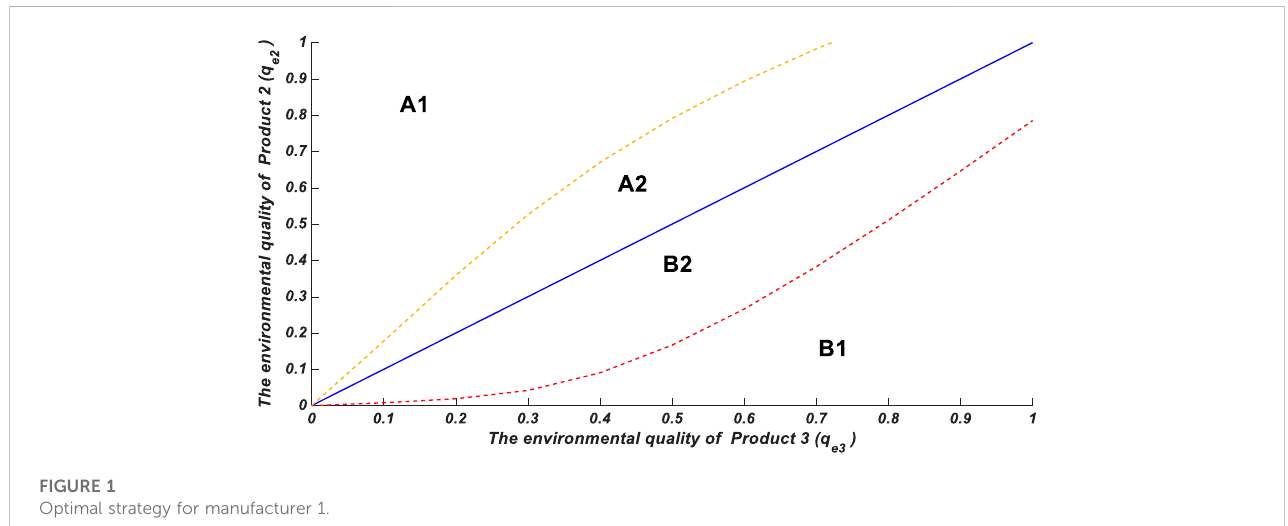
FIGURE 1 Optimal strategy for manufacturer